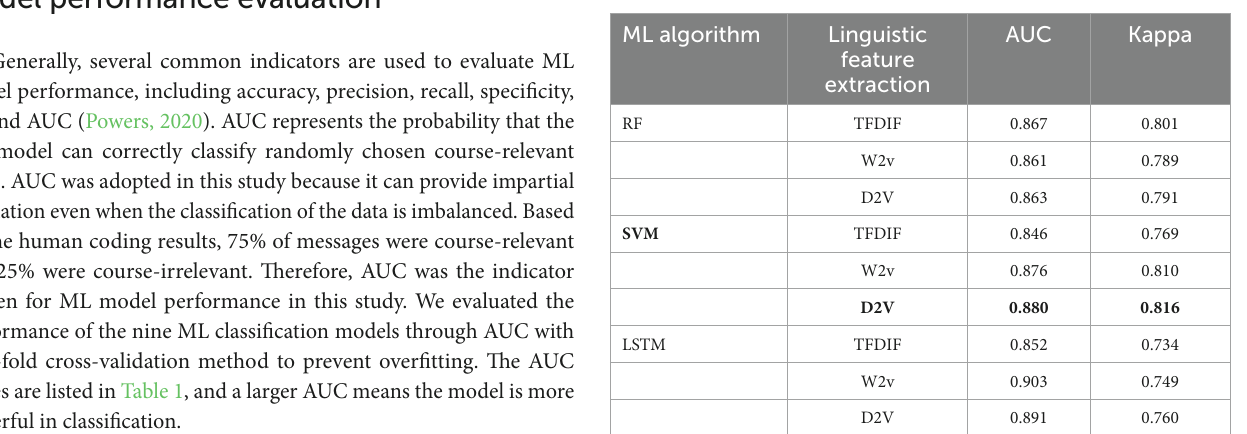
TABLE 1 ML model performance evaluation.